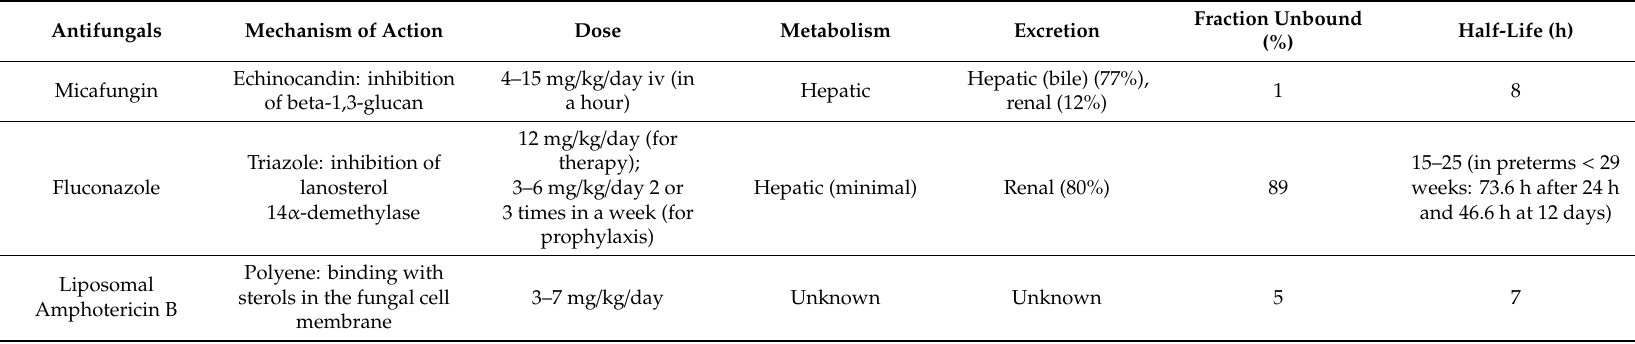
Table 2. Pharmacokinetics of most common antifungals titrated with TDM in newborns (modified from Roberts et al. [103] and Bersani et al. [104]). iv,